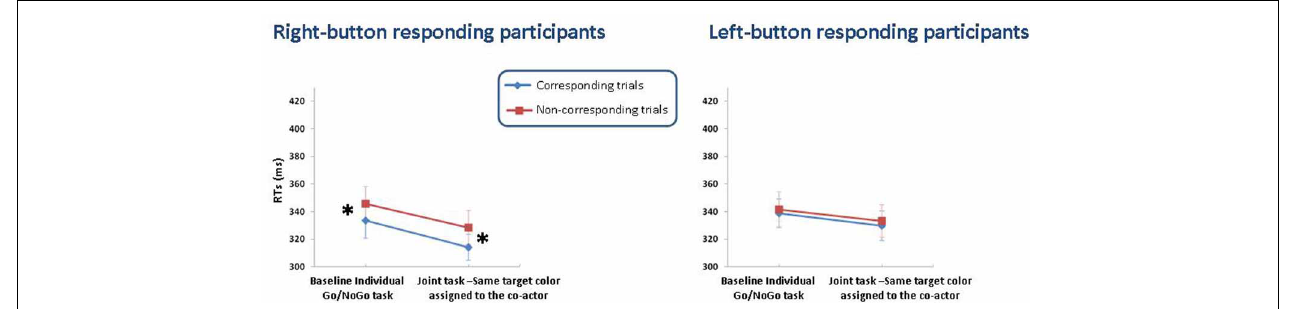
FIGURE 3 | Means ( ± S.E.M.s) of correct RTs for right- and left-button responding participants in Experiment 2. RTs are plotted as a function of task (baseline vs. joint task) and spatial correspondence (corresponding vs.